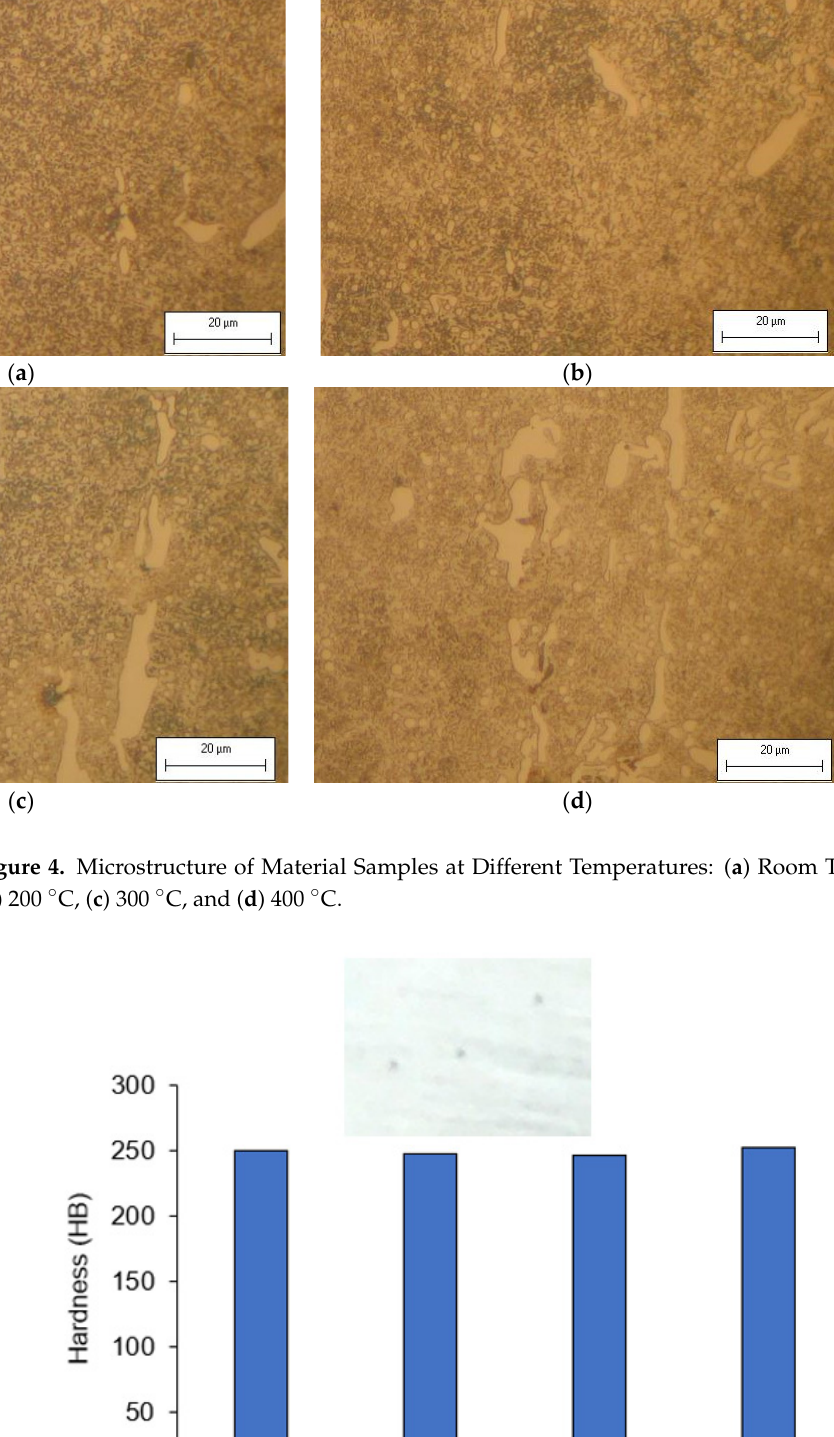
Figure 4. Microstructure of Material Samples at Di ff erent Temperatures: ( a ) Room Temperature, ( b ) 200 °C, ( c ) 300 °C, and ( d ) 400 °C.